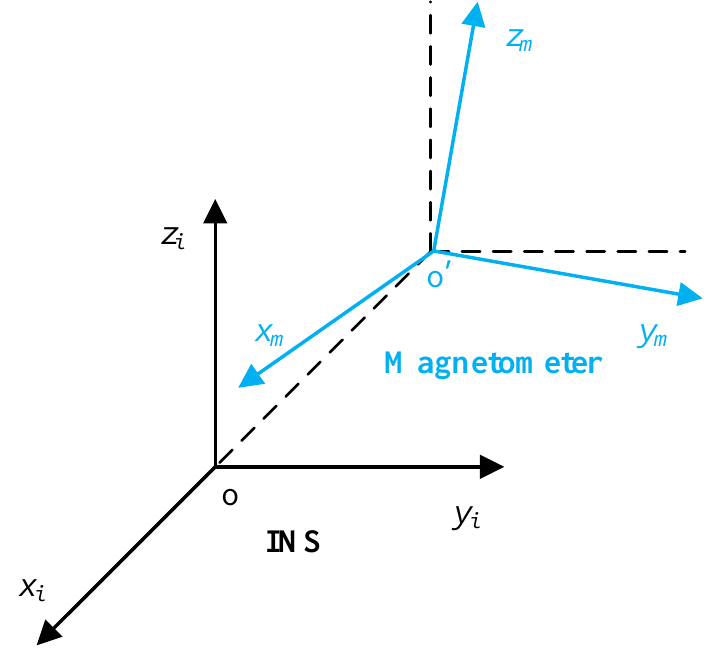
Figure 1. The diagram of misalignment error between a magnetometer and an inertial navigation system (INS).